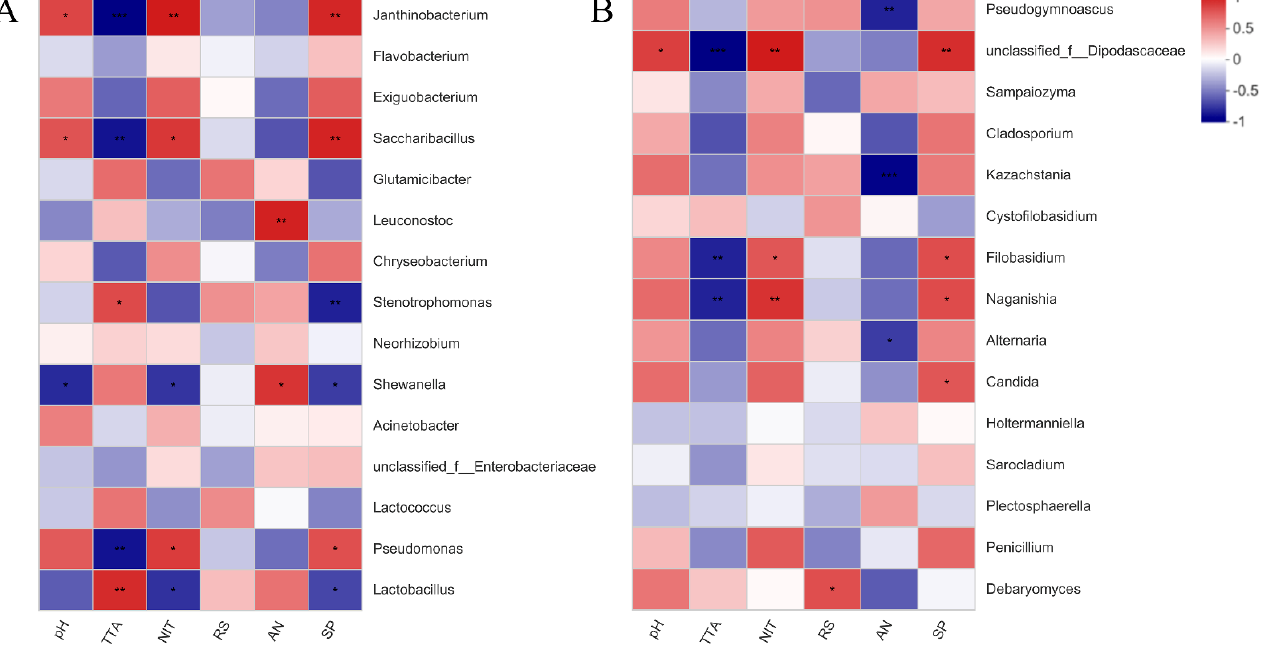
Figure 6. Microbe − environmental factors correlation heatmap showing associations between bacte- rial and the environmental factors ( A ), fungi and the environmental factors ( B ) based on the Person index. (Red denotes negative correlation, blue denotes positive correlation. * p < 0.05, ** p < 0.01,*** p < 0.001). Correlation analysis between environmental factors and the top 15 species was car- ried out, and the results are shown in Figure 6B. Titratable acid (TTA) was significantly negatively correlated with Naganishia , Filobasidium , and Dipodascaceae , nitrite (NIT) was significantly positively correlated with Naganishia , Filobasidium , and Dipodascaceae , and the amino acid nitrogen (AN) was significantly negatively correlated with Kazachstania and Pseudogymnoascus . The soluble protein (SP) was significantly positively correlated with Dipodascaceae , Naganishia , and Filobasidium , Candida